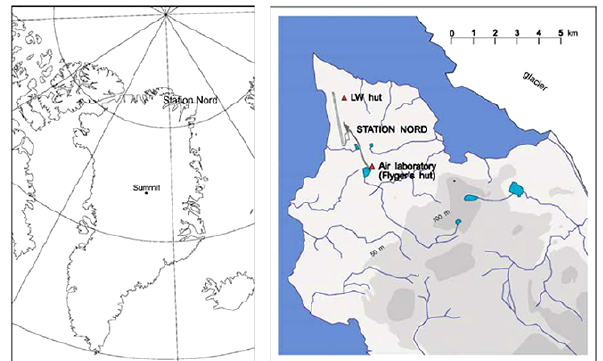
Figure 1. The high Arctic site Villum Research Station, Station Nord (81 ◦ 36 (cid:48) N, 16 ◦ 40 (cid:48) W; 30ma.s.l.), in northeast Greenland. The main measurement site is Flyger’s hut, which is located about 2.5km southeast of the Danish military